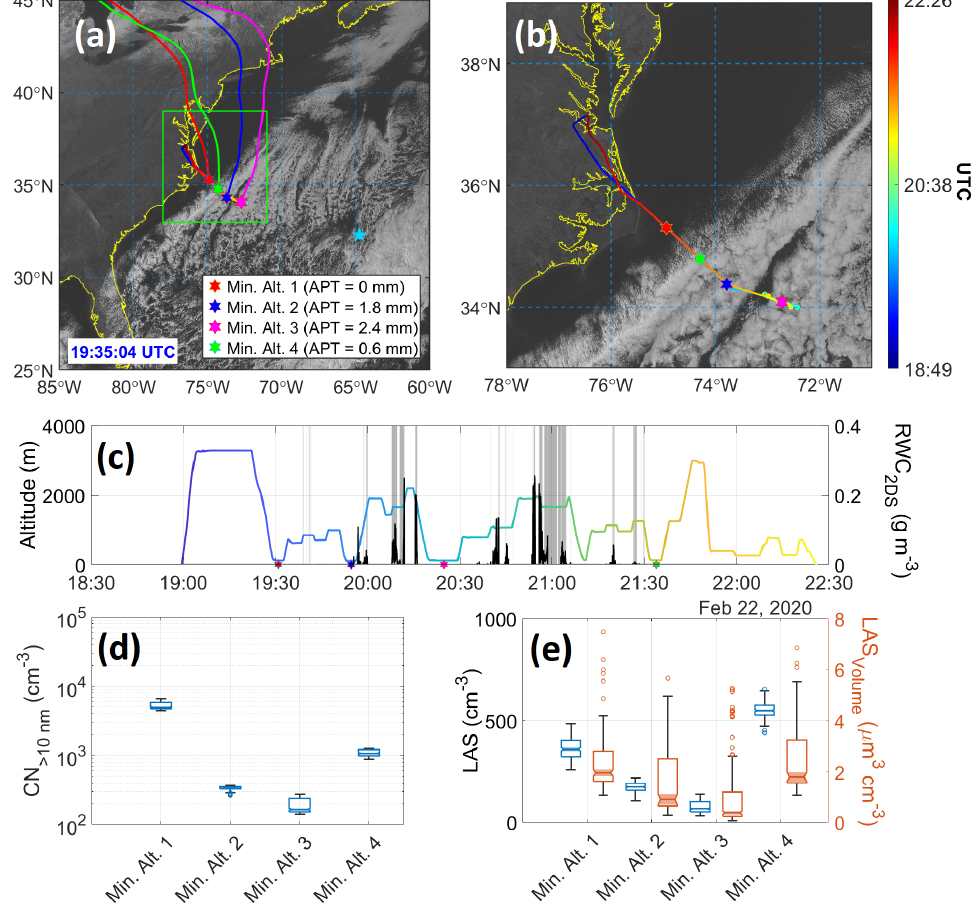
Figure 10. Summary of ACTIVATE’s Research Flight 6 on 22 February 2020. (a) HU-25 Falcon flight track overlaid on GOES-16 imagery of the WNAO (Bermuda denoted by blue star) also showing 96h back trajectories calculated for each respective min. alt. leg. The midpoints of the four min. alt. legs are marked, including values for the accumulated precipitation along the trajectory (APT) for the recent history of the sampled air masses when they were over the ocean (time over land excluded from APT calculation). (b) Zoomed-in version of panel (a) focused on the flight path. (c) Time series of Falcon altitude colored by flight UTC time (color bar in panel b ) and rain water content (RWC) from the 2DS probe. Gray shaded bars signify when FCDP liquid water content exceeded 0.05gm − 3 , indicative of cloud legs. The same four colored stars from (a) are shown on the x axis to indicate where they occurred. (d–e) Box notch plots of the leg-mean min. alt. values of CPC particle concentration ( > 0.01µm) and the number and volume concentrations of the LAS ( >